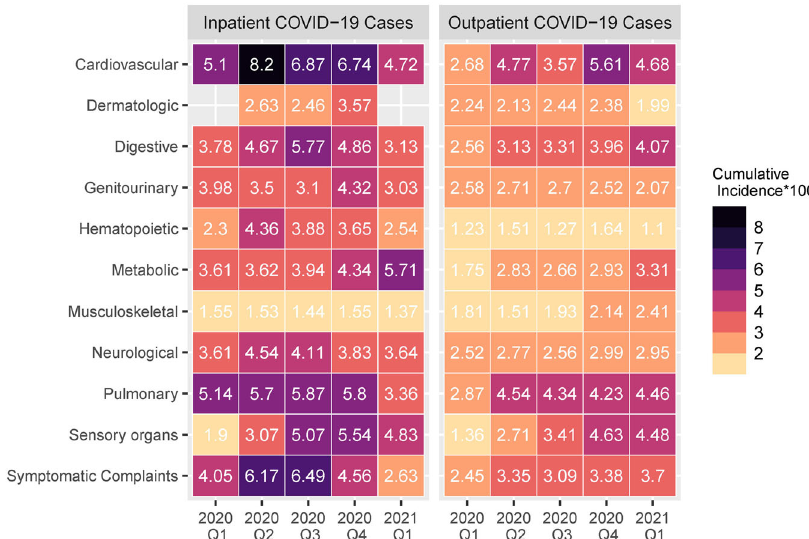
Fig. 5 Cumulative incidence of various conditions at the mid-stage post-acute period (30 to 89 days after initial infection) by the calendar quarter of their initial infection date. Left panel shows cumulative incidence among inpatient COVID-19 cases. Right panel shows cumulative incidence among outpatient COVID-19